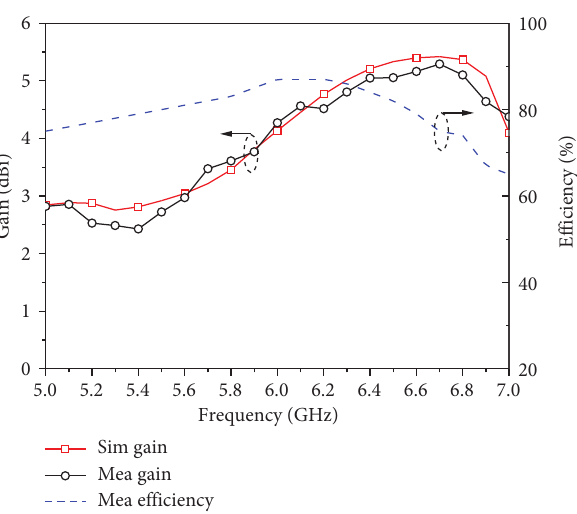
Figure 15: Gain and efficiency of the antenna. Table 2: Comparison of the wideband patch